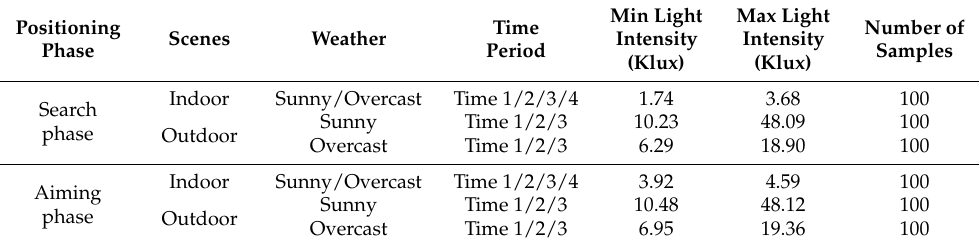
Table 5. Plug-in data